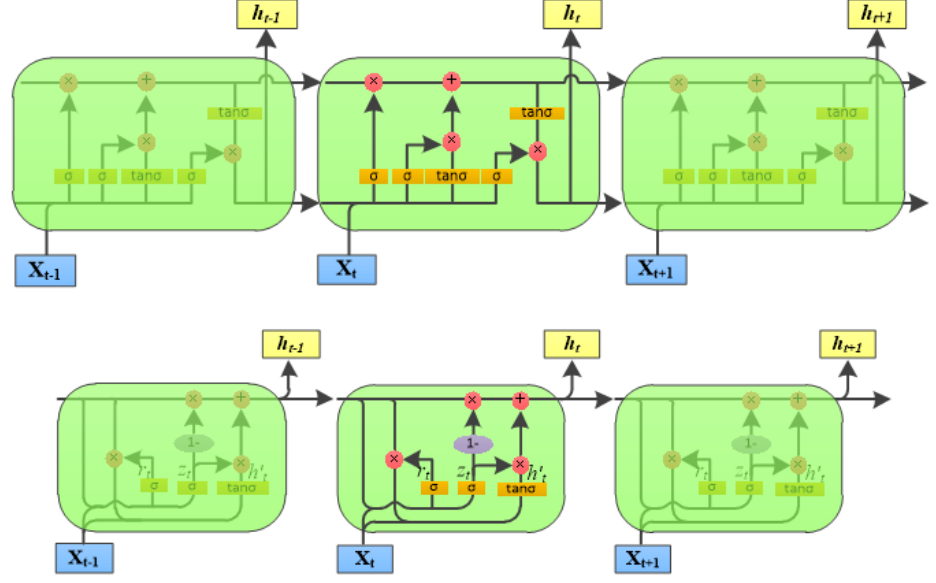
Figure 2. Structure diagram of long short-term memory (LSTM) and gated recurrent unit (GRU) methods. The upper part is LSTM [25] and the lower part is GRU [27]. indicates the sigmoid and tanh neural network layers. represents the pointwise multiplication and addition operations. is the operation subtracted by 1. depicts the input time series data. exhibits the output data.